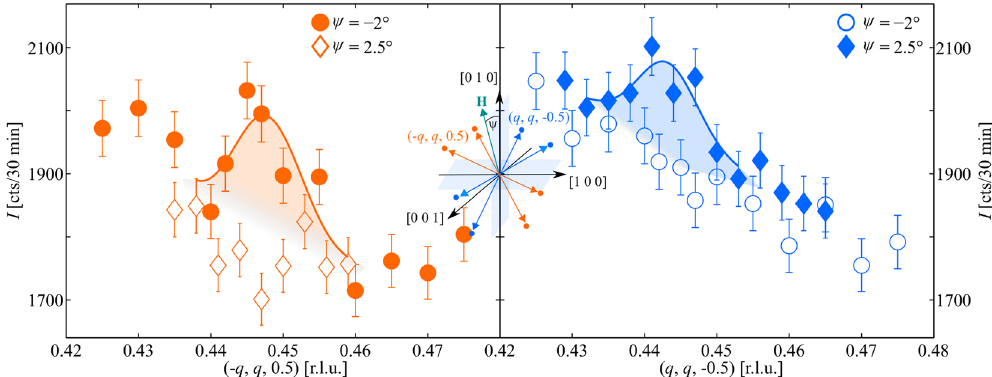
Figure 1. Switching in the Q-phase. Diffracted neutron intensity along the tetragonal plane of representatives of the two magnetic domains, Q 1 = ( q , q , 0.5) and Q 2 = ( q , - q , 0.5), measured at μ 0 H = 10.4 T and T = 40 mK for ψ = 2.5 and − 2°. Solid lines represent Gaussian fits on a sloping background.